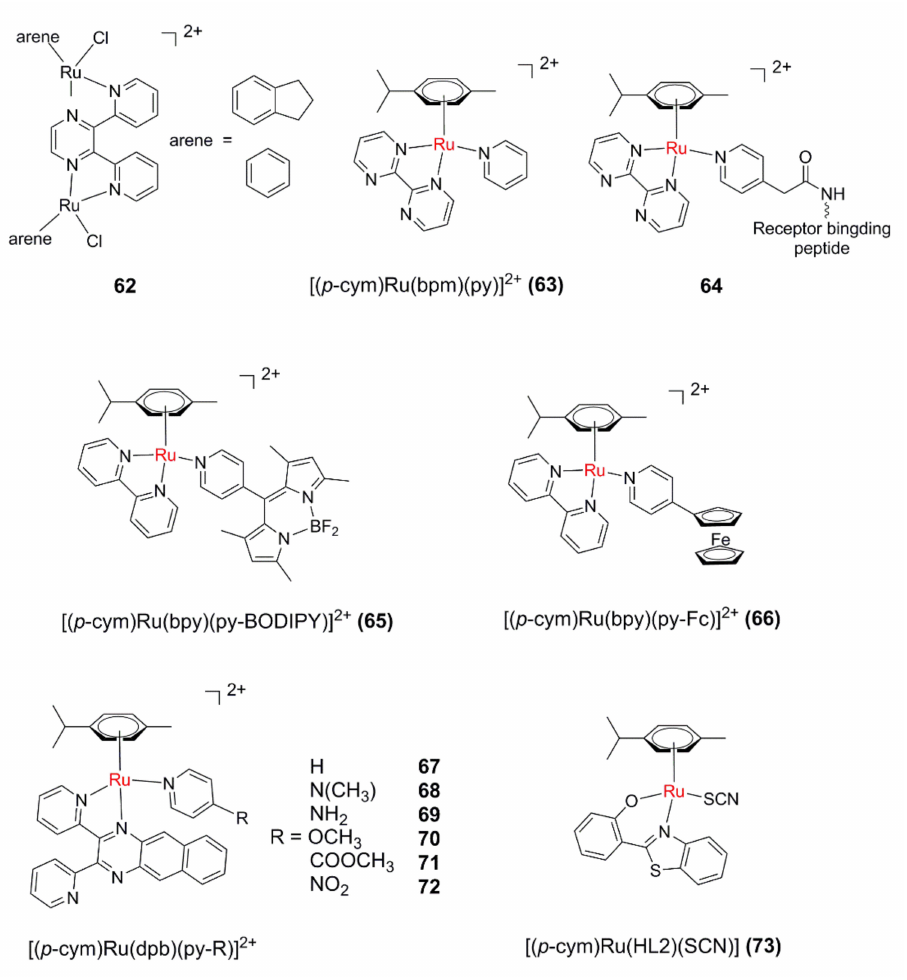
Figure 10. Ru(II)-arene-complexes-based PACT